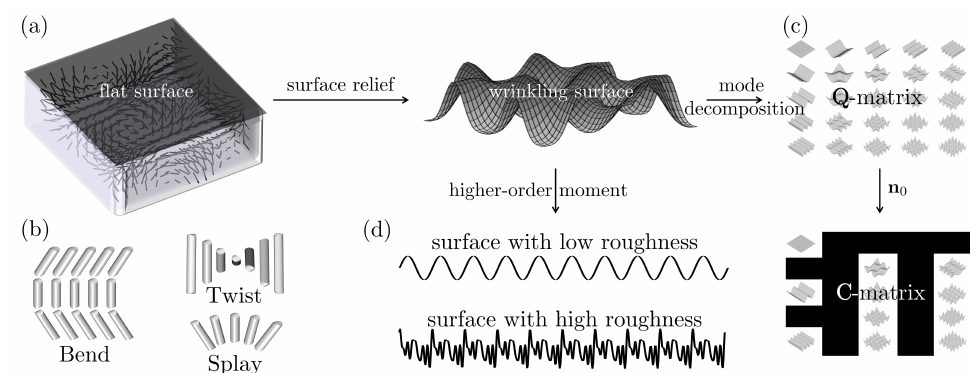
Figure 2. Schematic of this research. ( a ) A cholesteric liquid crystal tends to have a wrinkled surface rather than a flat surface driven by the director field (short lines) and the gradient of the director field. ( b ) The gradient of the director field shows three primary elastic modes: splay, bend and twist. ( c ) The wrinkling surface is the summation of various simple wrinkling modes, whose contributions are integrated into the C -matrix of fundamental wrinkling modes (shown in Equation (15)). ( d ) The higher-order moment of the wrinkling surface characterizes the surface